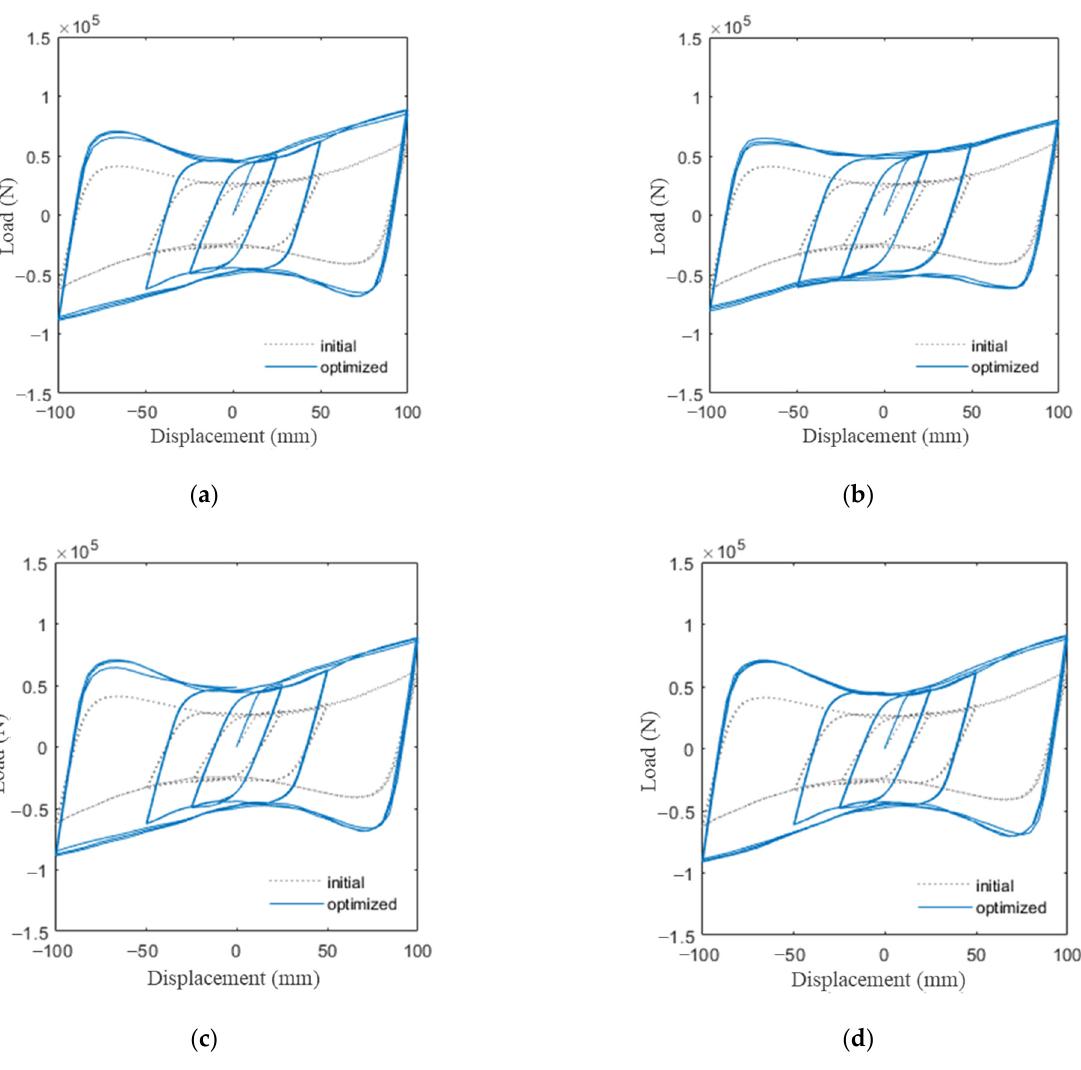
Figure 8. Hysteresis loops of the optimized shapes: ( a ) Case S1; ( b ) Case S2; ( c ) Case S3; and ( d ) Case S4.